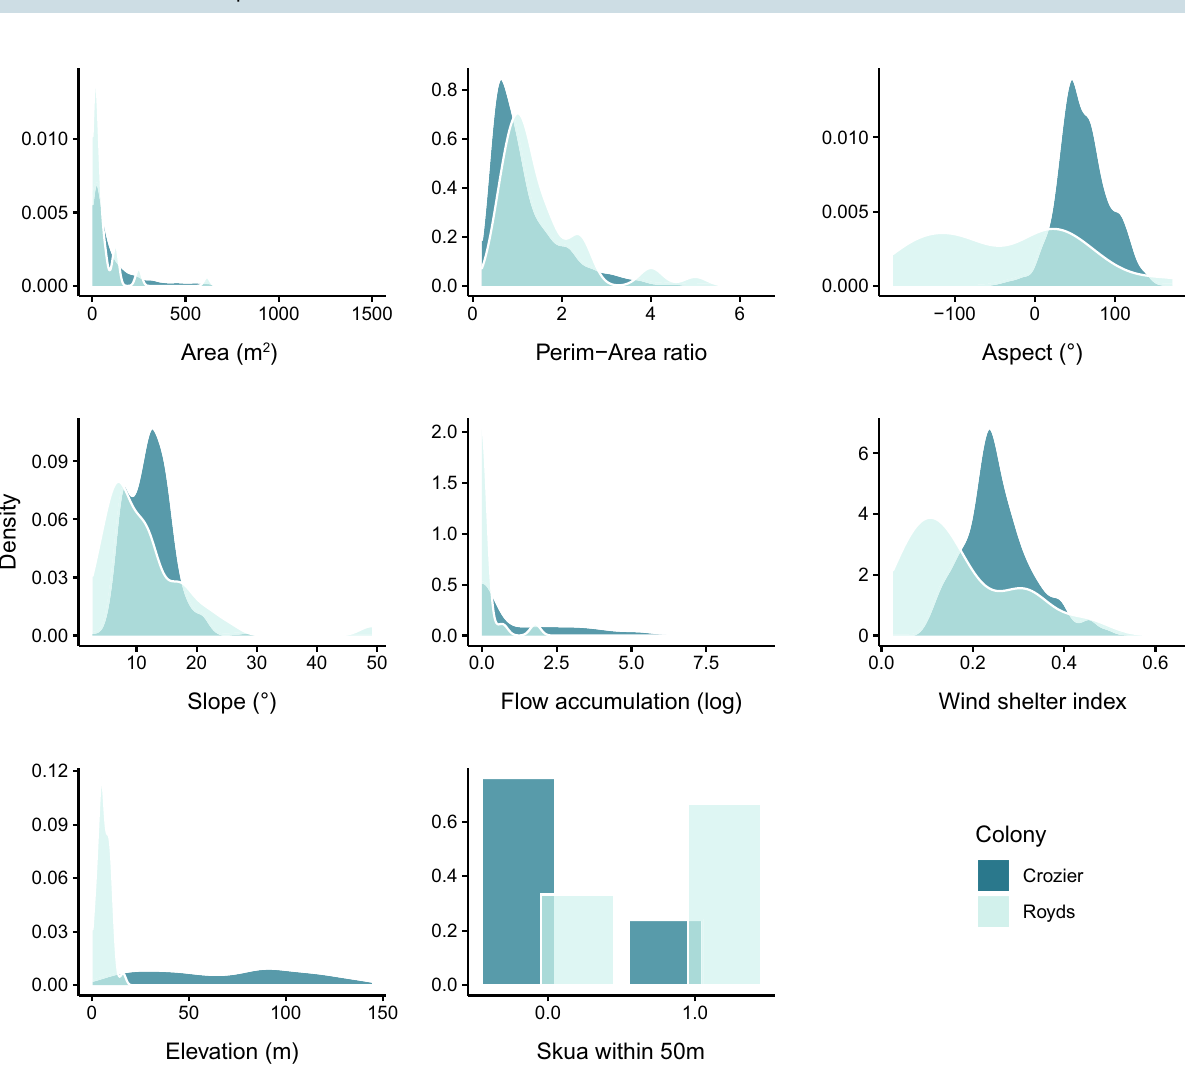
Figure 3. Distributions of spatial habitat covariates for all subcolonies at Cape Crozier and Cape Royds, Ross Island, Antarctica. Means of all covariates were statistically different between the two colonies. Last panel indicates the number of subcolonies that have at least one skua nest within 50 m (0 = no skua nest, 1 = skua nest within 50 m). The distribution of subcolony areas at Cape Crozier had an extremely long tail so 21 (out of 723) subcolonies with areas greater than 1500 m 2 were excluded from this figure to aid visualization. The max subcolony area at Cape Crozier was 9568 m 2 .